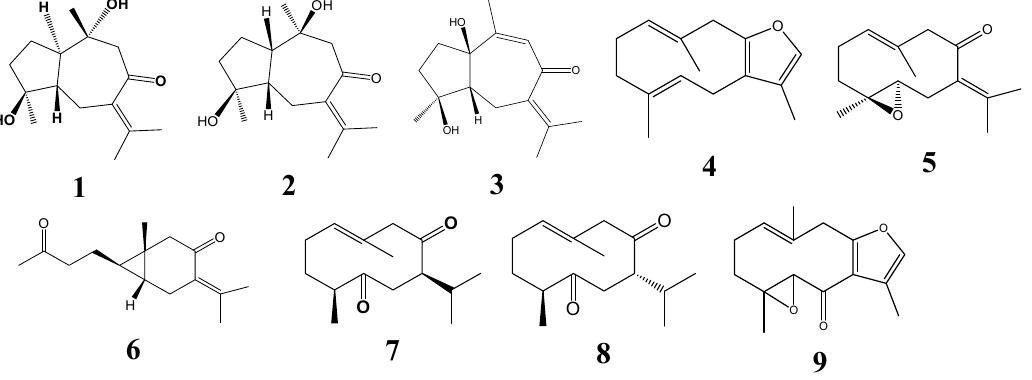
Figure 1. The structures of compounds 1 – 9 .